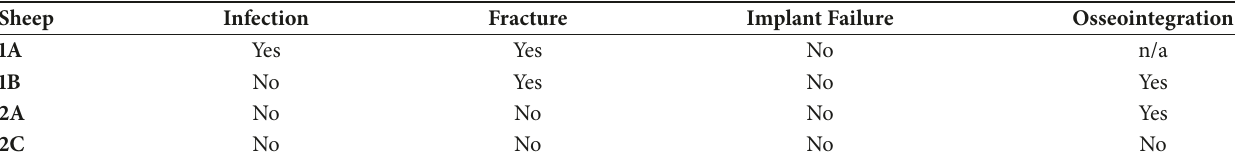
Table 1: Results overview.